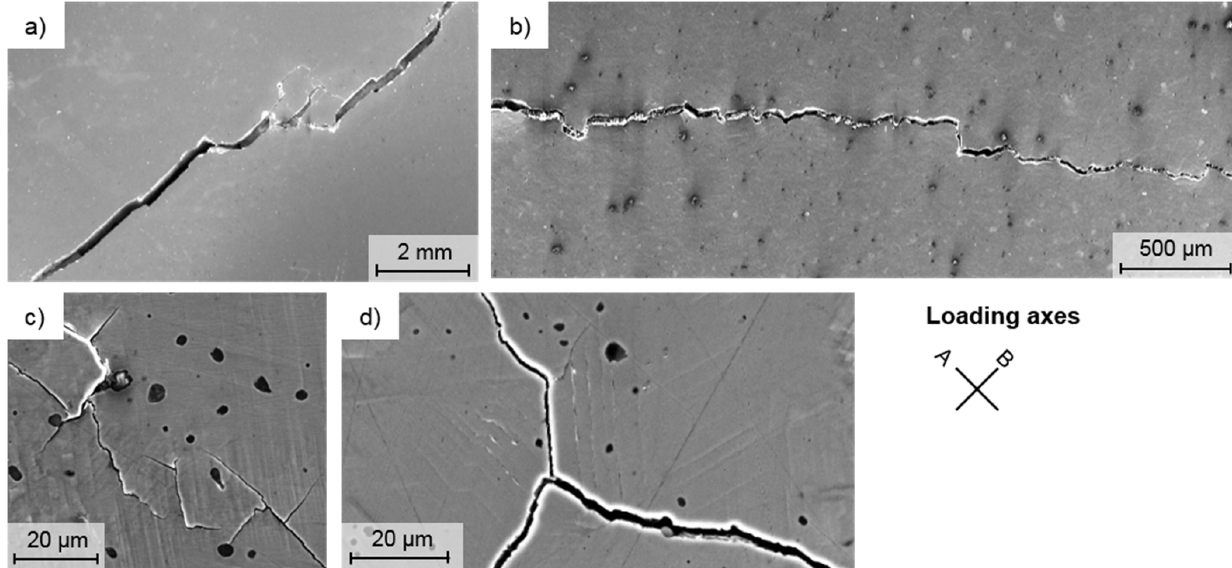
Figure 7: Micrographs of surface cracks after biaxial cycling with  = -1 (a, c) and  = 1 (b, d) at Δ  vM /2 = 0.4 · 10 -2 of TRIP steel PM 16-7-6. Major cracks (a, b) and cracks smaller than 0.1 mm (c, d) show crack branching.